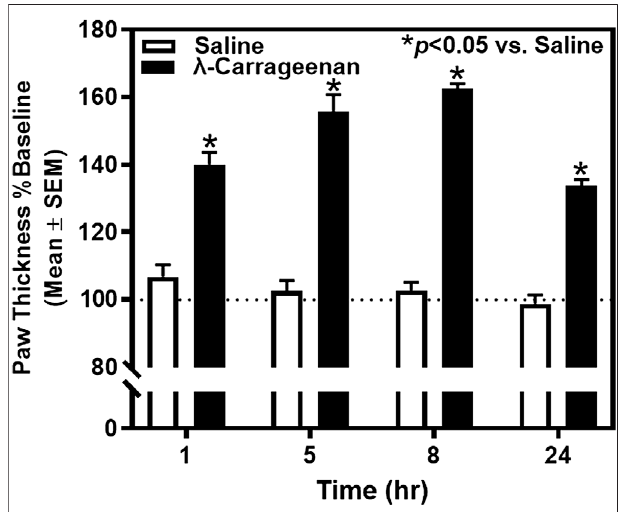
FIGURE 2 | The effect of λ -carrageenan (1%; i.p.l.) on paw thickness across 24 h is presented. The percentbaseline paw thickness was calculated as the mean value at each time point following treatment with saline (white bars) or λ -carrageenan (black bars), normalized to baseline values. λ - Carrageenan signi fi cantly increased paw thickness relative to saline at all time points (* p < 0.05 vs.